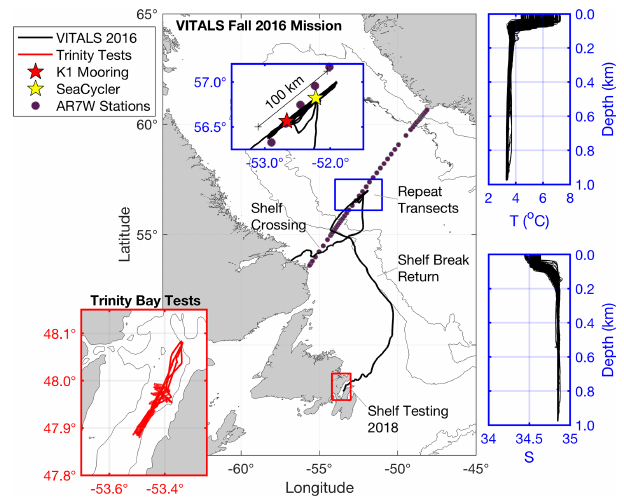
Figure 1. Map of data collection sites: the main map (center) shows the Ventilation, Interaction and Transport Across the Labrador Sea (VITALS) glider track, with the blue inset focusing on the repeat transects along the AR7W line. Contours are the 1500 and 3000m isobaths. Highlighted in blue are also the corresponding T – S pro- files collected by the glider in that time period. Salinity is given in practical salinity units. The red inset map in the lower left shows the glider track from the 2018 glider CO 2 optode tests conducted in Trinity Bay,